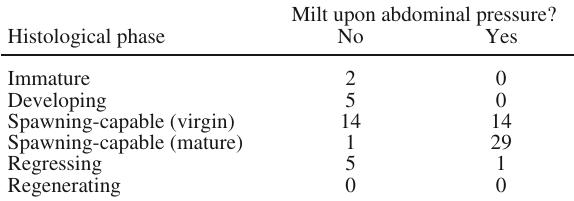
Table 5. – Meagre reaction to abdominal pressure during peak spawning season. Numbers are